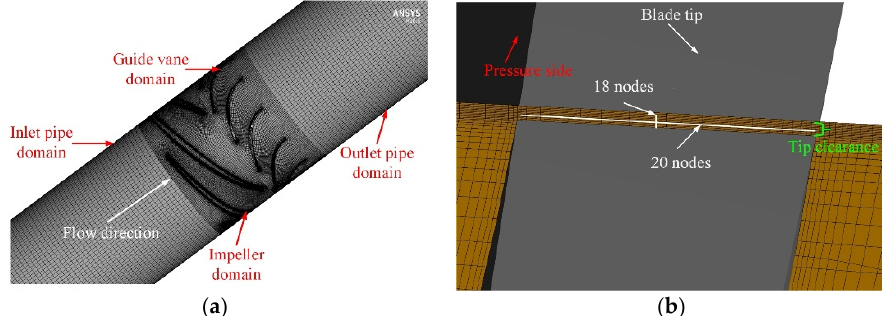
Figure 1. Tested multiphase pump.